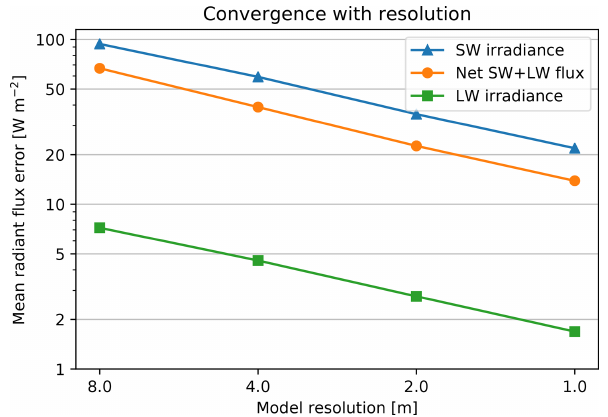
Figure 6. Double-logarithmic presentation of mean deviations of surface SW and LW irradiance as well as net radiant flux against the finest-resolution case of